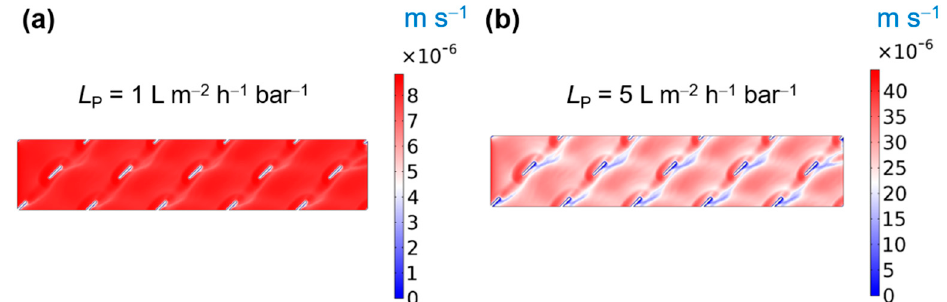
Figure 5. The water flux with inlet average velocity magnitude of 0.15 m s − 1 using the permeable wall model for ( a ) the commercial membrane ( L P = 1 L m − 2 h − 1 bar − 1 ) and ( b ) the HPM ( L P = 5 L m − 2 h − 1 bar − 1 ) systems.